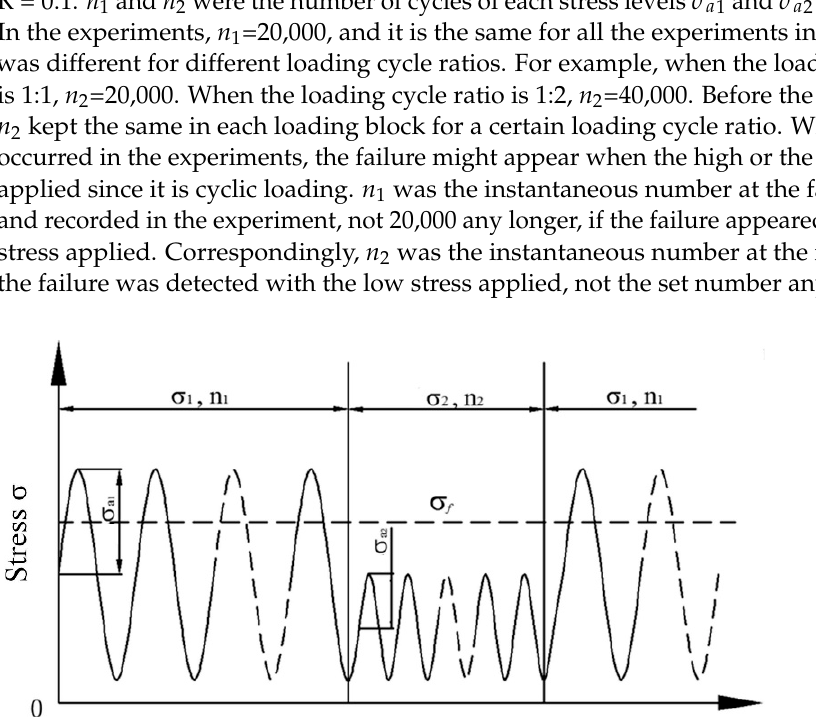
Table 3. Loading conditions of constant amplitude (CA) loading tests.